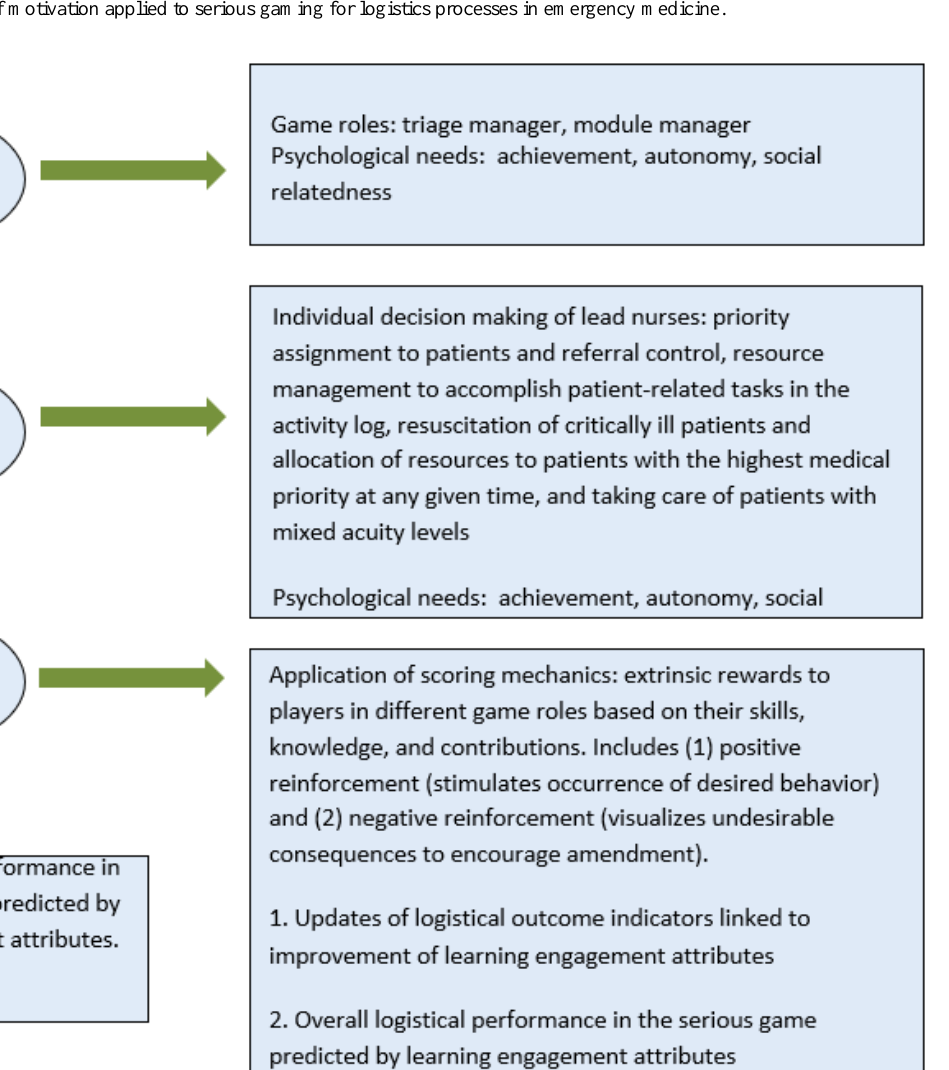
Figure 2. Reinforcement theory of motivation applied to serious gaming for logistics processes in emergency